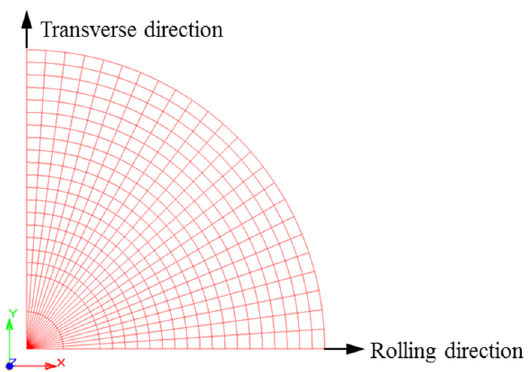
Figure 10. A quarter of the blank model. Table 2. Yield function coefficients of AA2090-T3 [33]. Adapted from Ref. [33] with permission from Elsevier (2021).